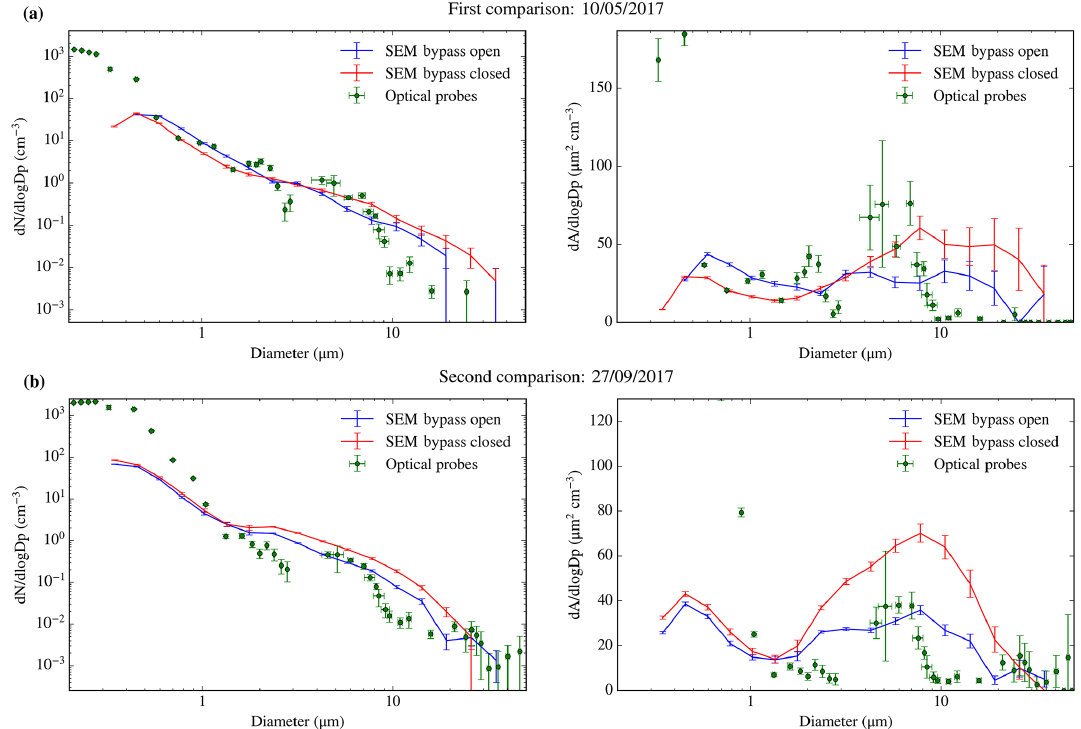
Figure 8. (a) First bypass test carried out during the C010 flight on 10 May 2017 from 11:24 to 11:38UTC. The lower line sampled 226L with the bypass closed, whereas the upper line sampled 141 L with the bypass open at an altitude of about 150 m. The flow rates were 16.1 and 10.6L min − 1 respectively. (b) Second bypass test carried out during the C057 flight on 27 September 2017 from 13:33 to 13:50UTC. The lower line sampled 555 L with the bypass open, whereas the upper line sampled 499L with the bypass closed, at about 240m. The flow rates were 34.7 and 31.2Lmin − 1 respectively. The position of the closed and open lines was swapped with respect to the first comparison. The sampling was interrupted for a minute to avoid a turn. Both comparisons are shown in both number size distribution and surface area size distribution. The optical probes are the PCASP–CDP, using the closest calibration to the sampling date and a refractive index of 1.56 as stated in Sect. 2.3. The only error source considered for the SEM size distribution is the Poisson counting